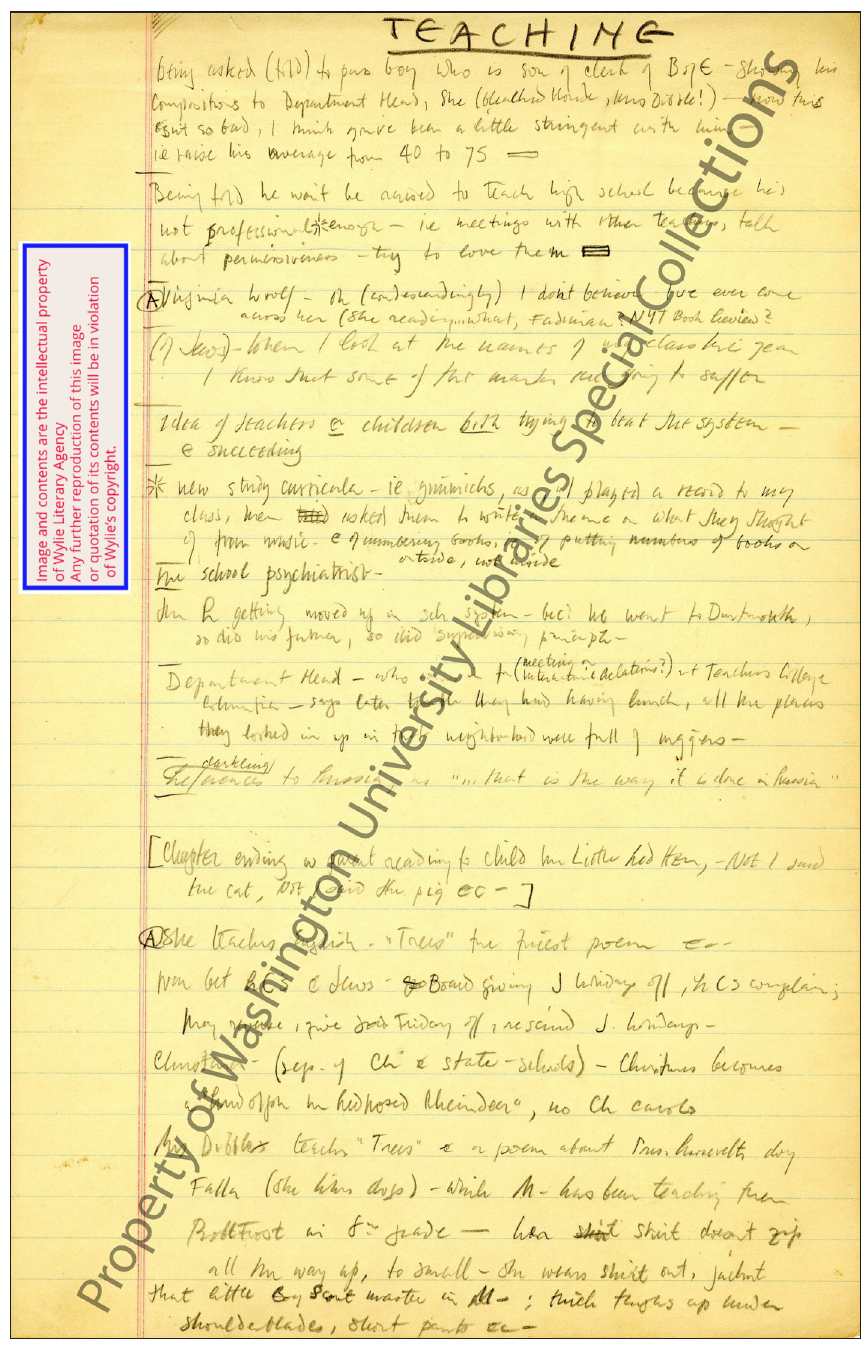
Figure 1: A list of potential “Teaching” plot-points for J R